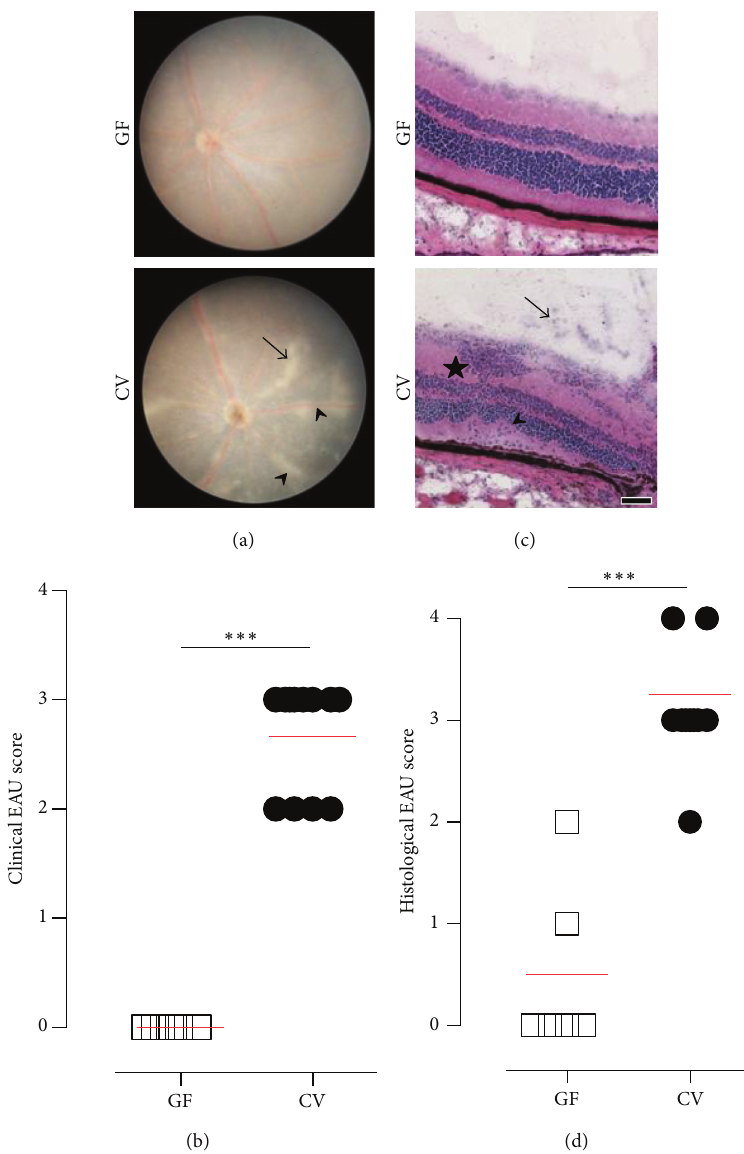
Figure 1: Severity of ocular inflammation in germ-free (GF) and conventional (CV) mice 35 days after EAU induction. (a) Representative photographs of retinal fundus of GF (grade 0) and CV (grade 2) mouse. The figure shows small and linear lesions (arrow), minimal optic disc inflammation, and moderate vascular cuffing (arrowheads). (b) Quantification of the clinical EAU score. By clinical fundoscopy, no inflammation was observed in the GF mice (3 animals) at day 35 after induction, whereas in control CV mice (6 animals), severe inflammation was observed. The red line in the graphs represents mean. ∗∗∗ 𝑝 < 0.001 (Mann-Whitney test). (c) Representative microphotographs of hematoxylin and eosin-stained retina of GF and CV mice. The figure shows a large infiltrate (star) located in inner retinal layer, mild vitritis (arrow), and small retinal folds (arrowhead). (d) Quantification of histological EAU score. On histological evaluation, minimal to no signs of uveitis were observed in GF mice (6 animals) compared to severe uveitis in CV mice (6 animals). The red line in the graphs represents mean. ∗∗∗ 𝑝 < 0.001 (Mann-Whitney